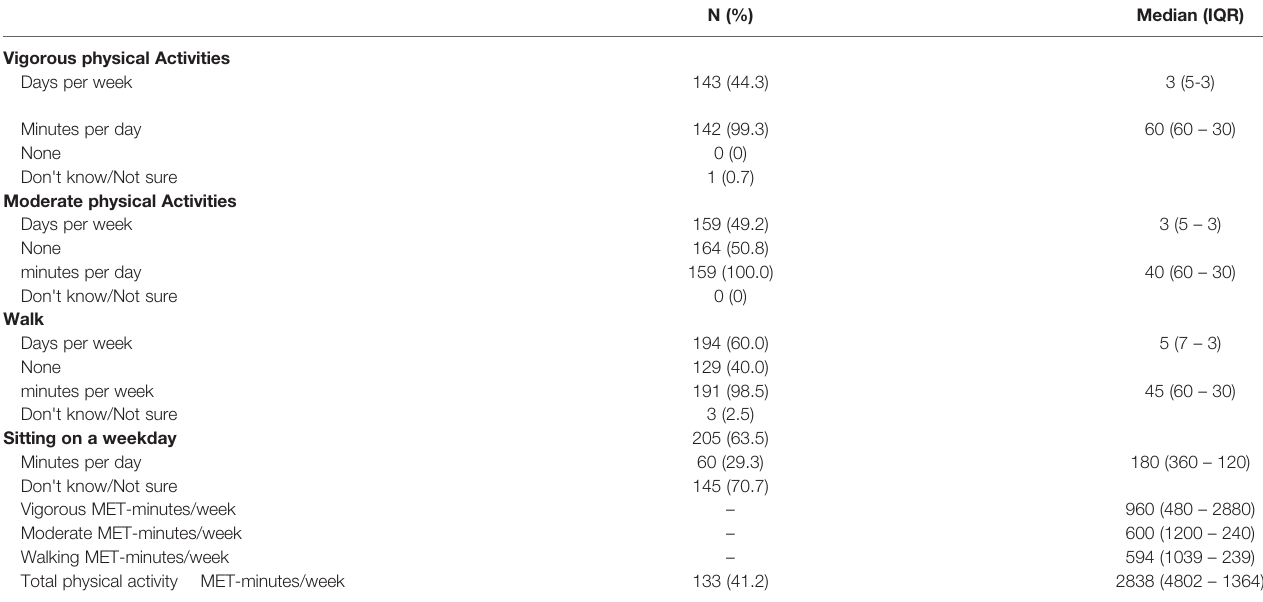
TABLE 5 | Descriptive statistics of physical activity measured by IPAQ.